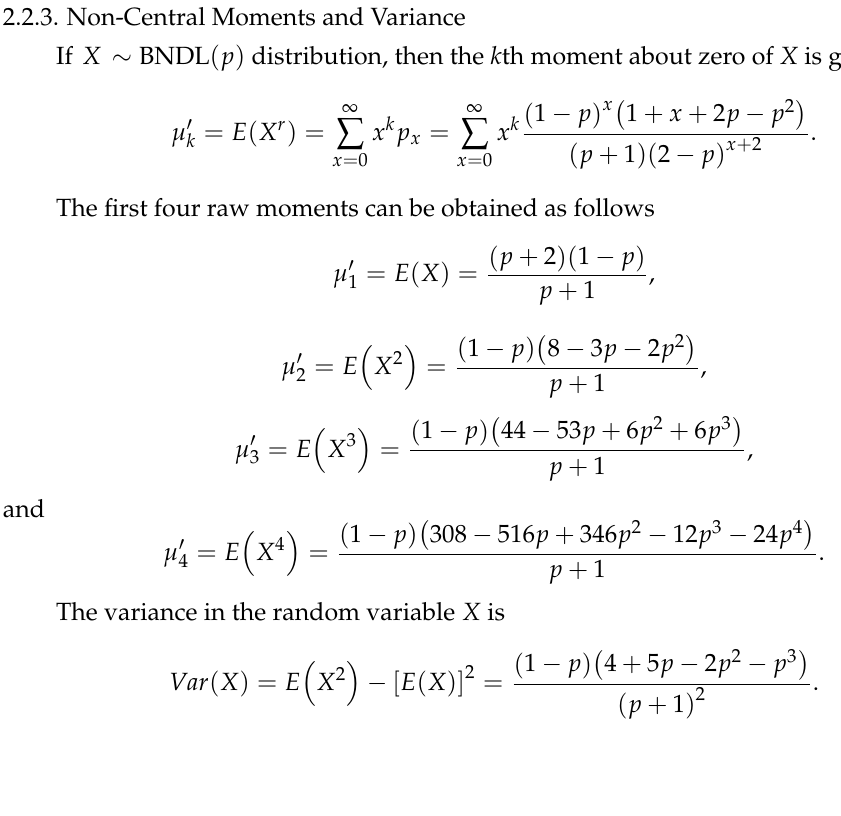
Figure 2. Histograms of the BNDL model for simulated data.